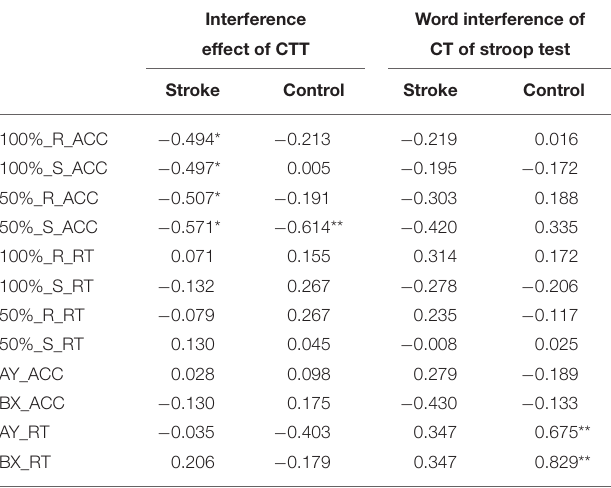
TABLE 7 | The relationship between the general executive functions and the performance in the task-switching paradigm and AX-CPT of the two groups of